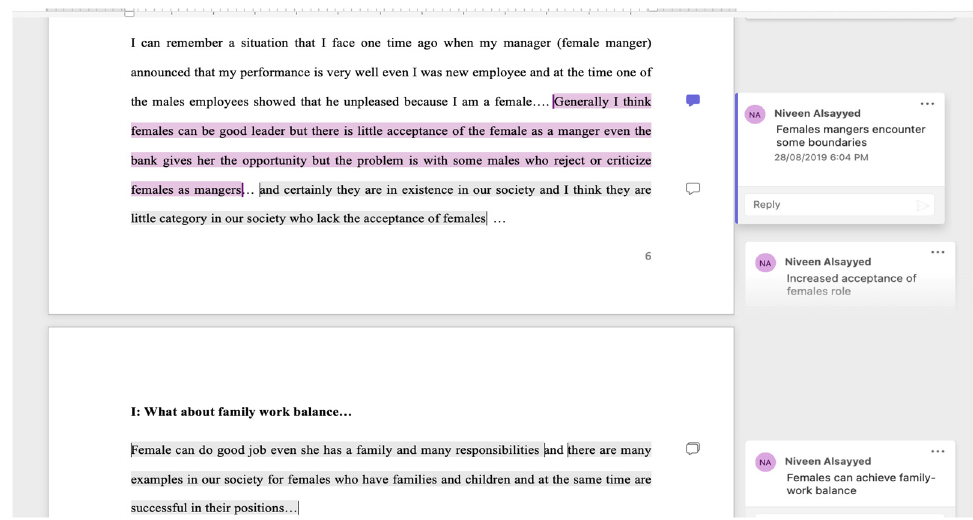
Figure 1. Sample interview with